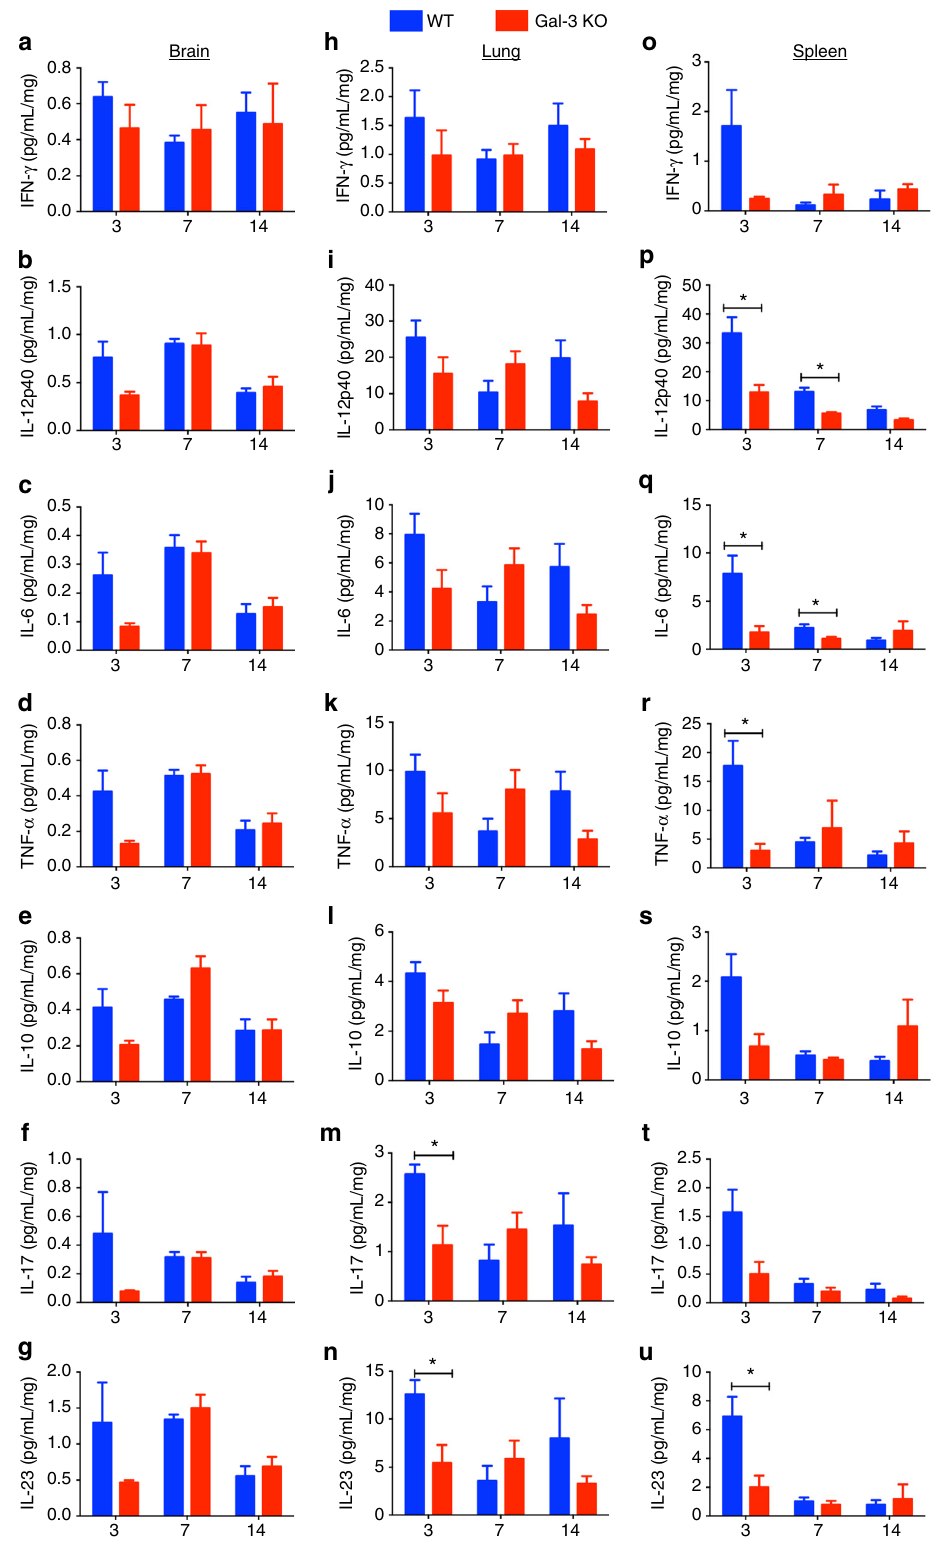
Fig. 4 Levels of relevant cytokines in the brain, lung, and spleen of C . neoformans -infected WT and Gal-3 KO mice. WT (blue bars) and Gal-3 KO (red bars) mice were intratracheally infected with a 50 μ l suspension containing 1×10 6 yeast cells. Organ samples were weighed and homogenized. The levels of the following cytokines in the brains ( a – g ), lungs ( h – n ), and spleens ( o – u ) (3, 7, and 14 days post-infection) of infected mice were determined by ELISA: IFN- γ , IL-12p40, IL-6, TNF- α , IL-10, IL-17, and IL-23. The results represent the mean ± SD of fi ve mice per group, from a representative experiment of three